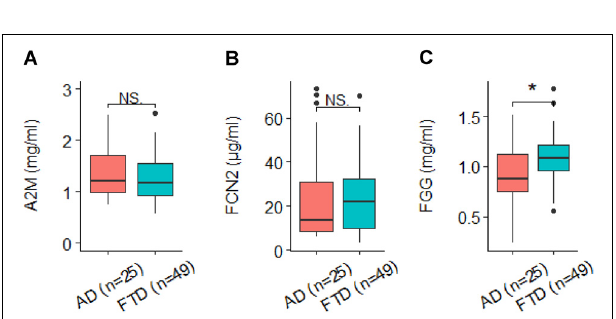
FIGURE 2 | (A) A2M, alpha-2-macroglobulin; (B) FCN2, ficolin-2; (C) FGG, fibrinogen gamma chain. Box plot of three proteins’ expression between AD and frontotemporal dementia (FTD). NS., not significant. ∗ p <